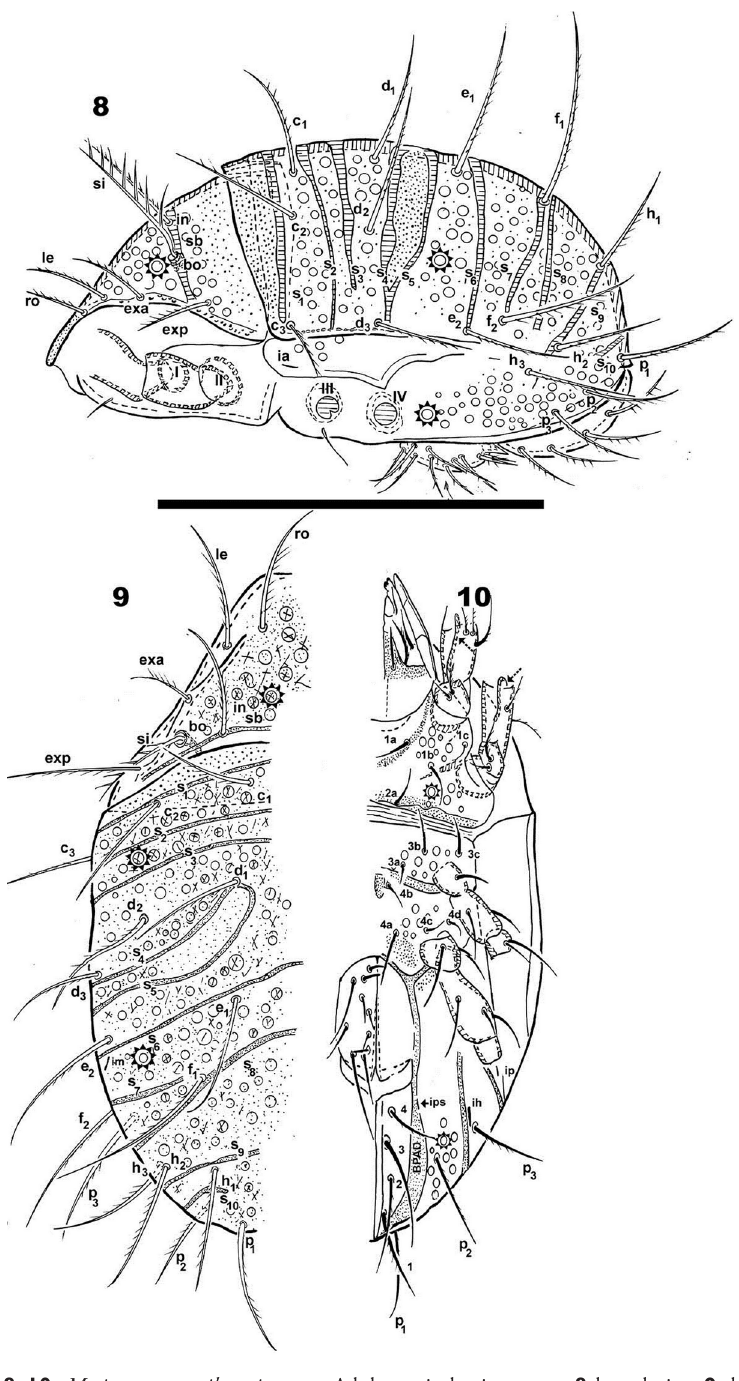
Figures 8–10. Meristacarus perikopesis sp. n. Adult, optical microscopy. 8 lateral view 9 dorsal view 10 ventral view. Scale bar: 600